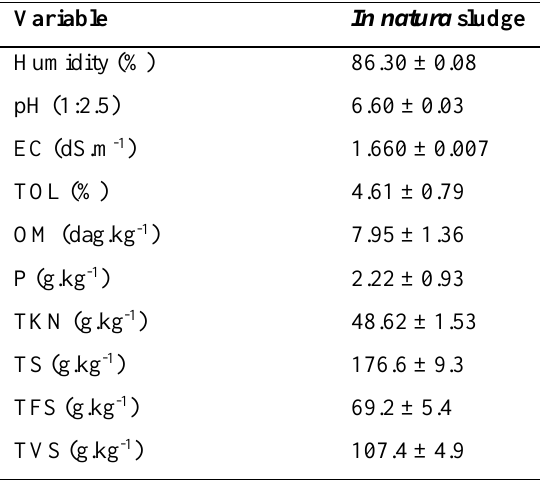
Table 2 Average values and standard deviation of the raw sewage sludge characteristics of the